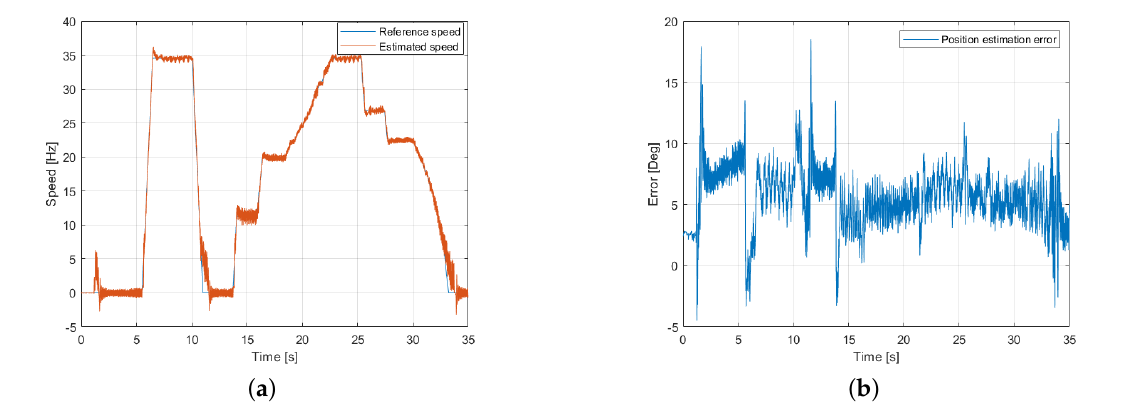
Figure 13. Sensorless drive at low speeds using the HF injection based estimator. ( a ) Speed tracking. ( b ) Position estimation error.